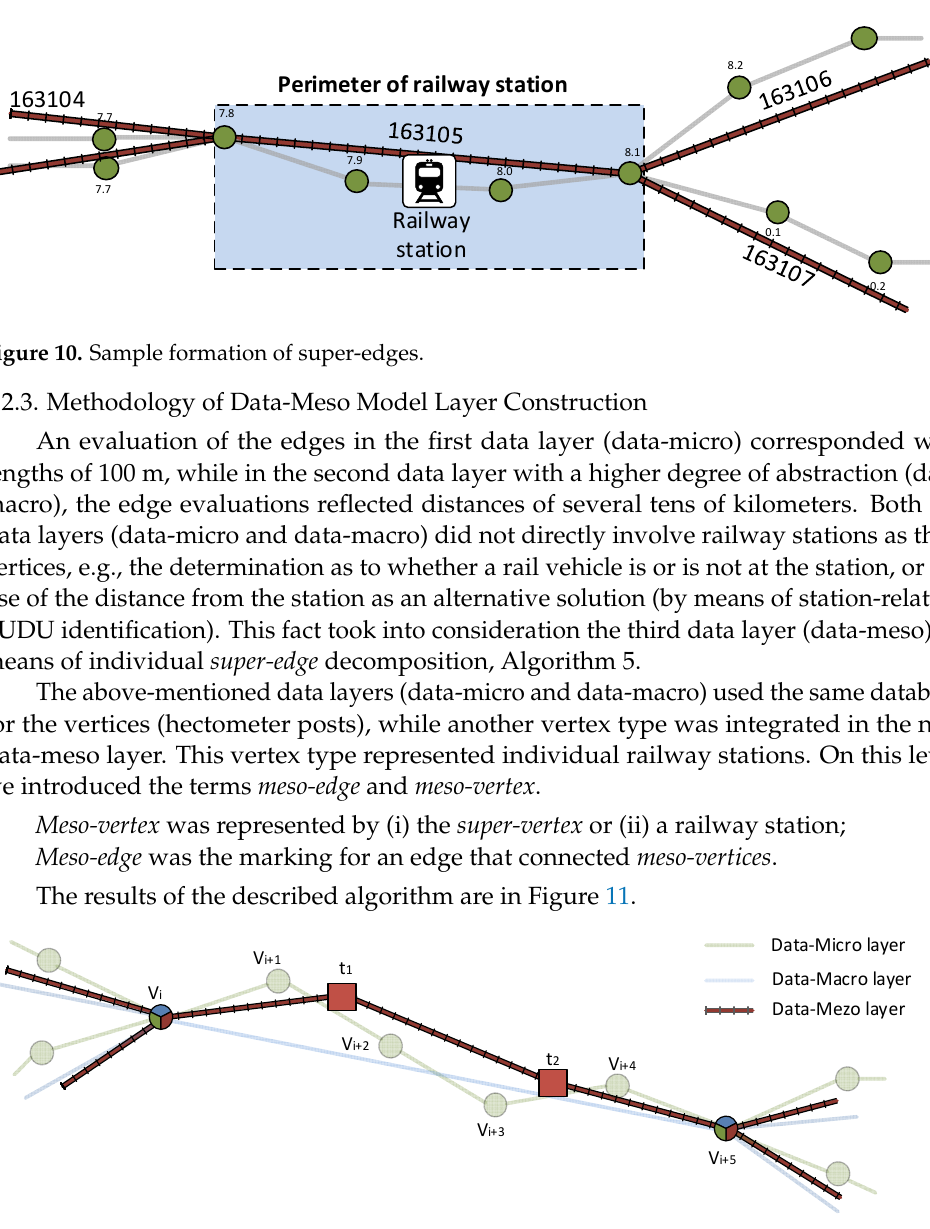
Algorithm 5. Algorithm concept of data-meso model layer construction.